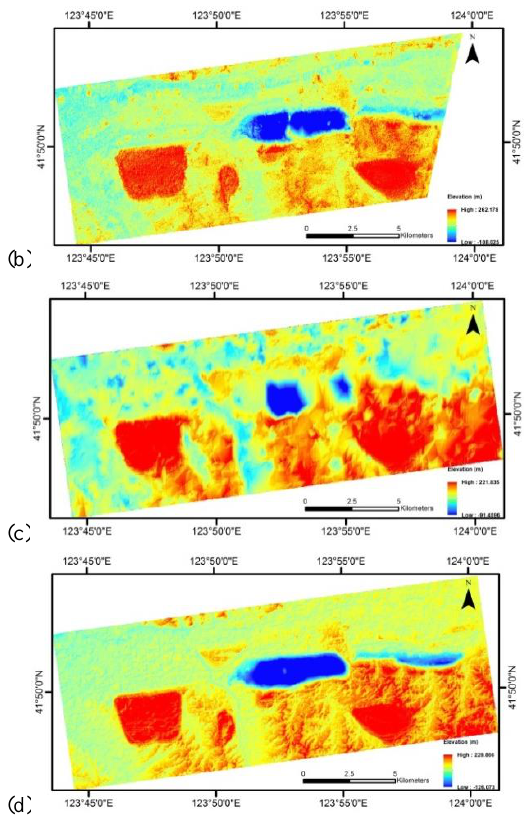
Figure 3 DEM in the study area. (a) ASTER GDEM; (b) ZY-3 DEM in 2013; (c) ZY-3 DEM in 2014; (d) ZY-3 DEM in 2015.